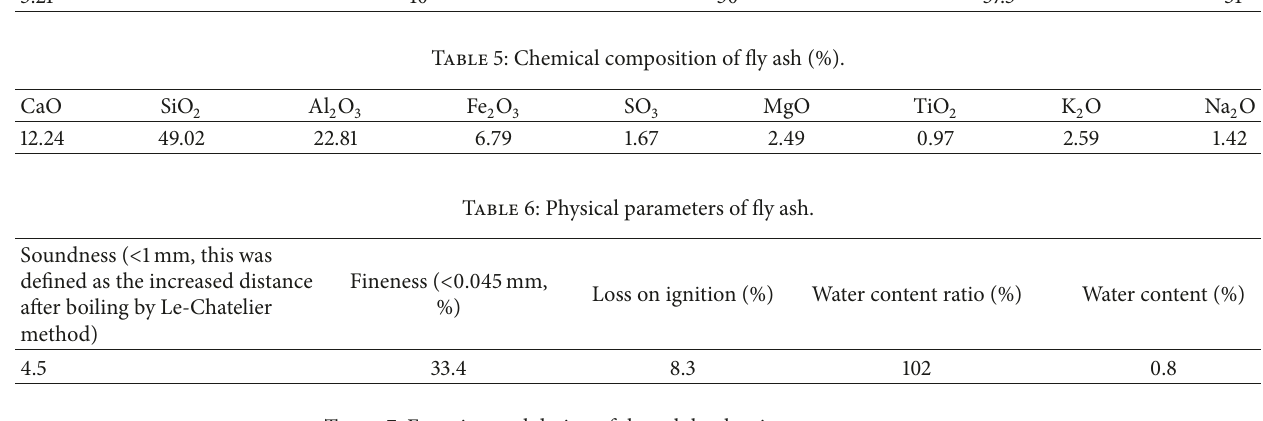
Table 7: Experimental design of the sulphoaluminate cement